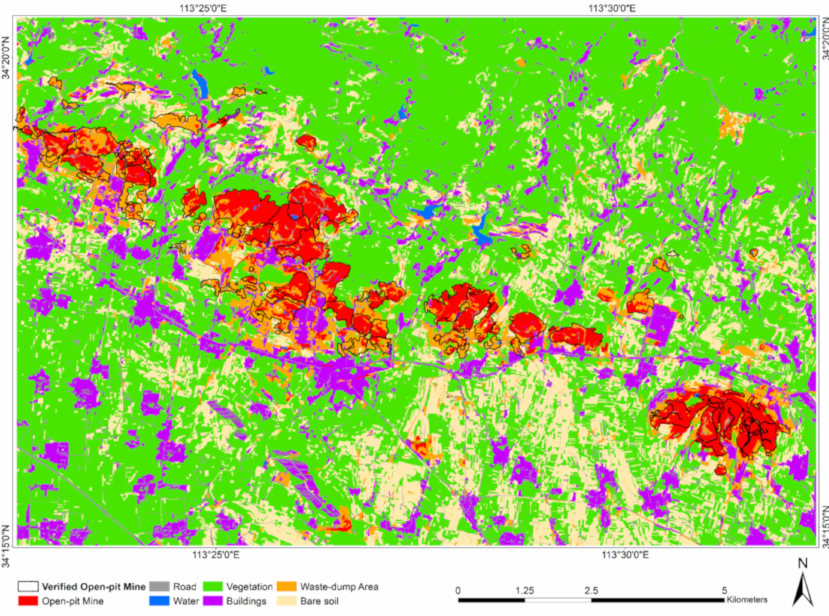
Figure 10. Results of CNN-based open-pit mine